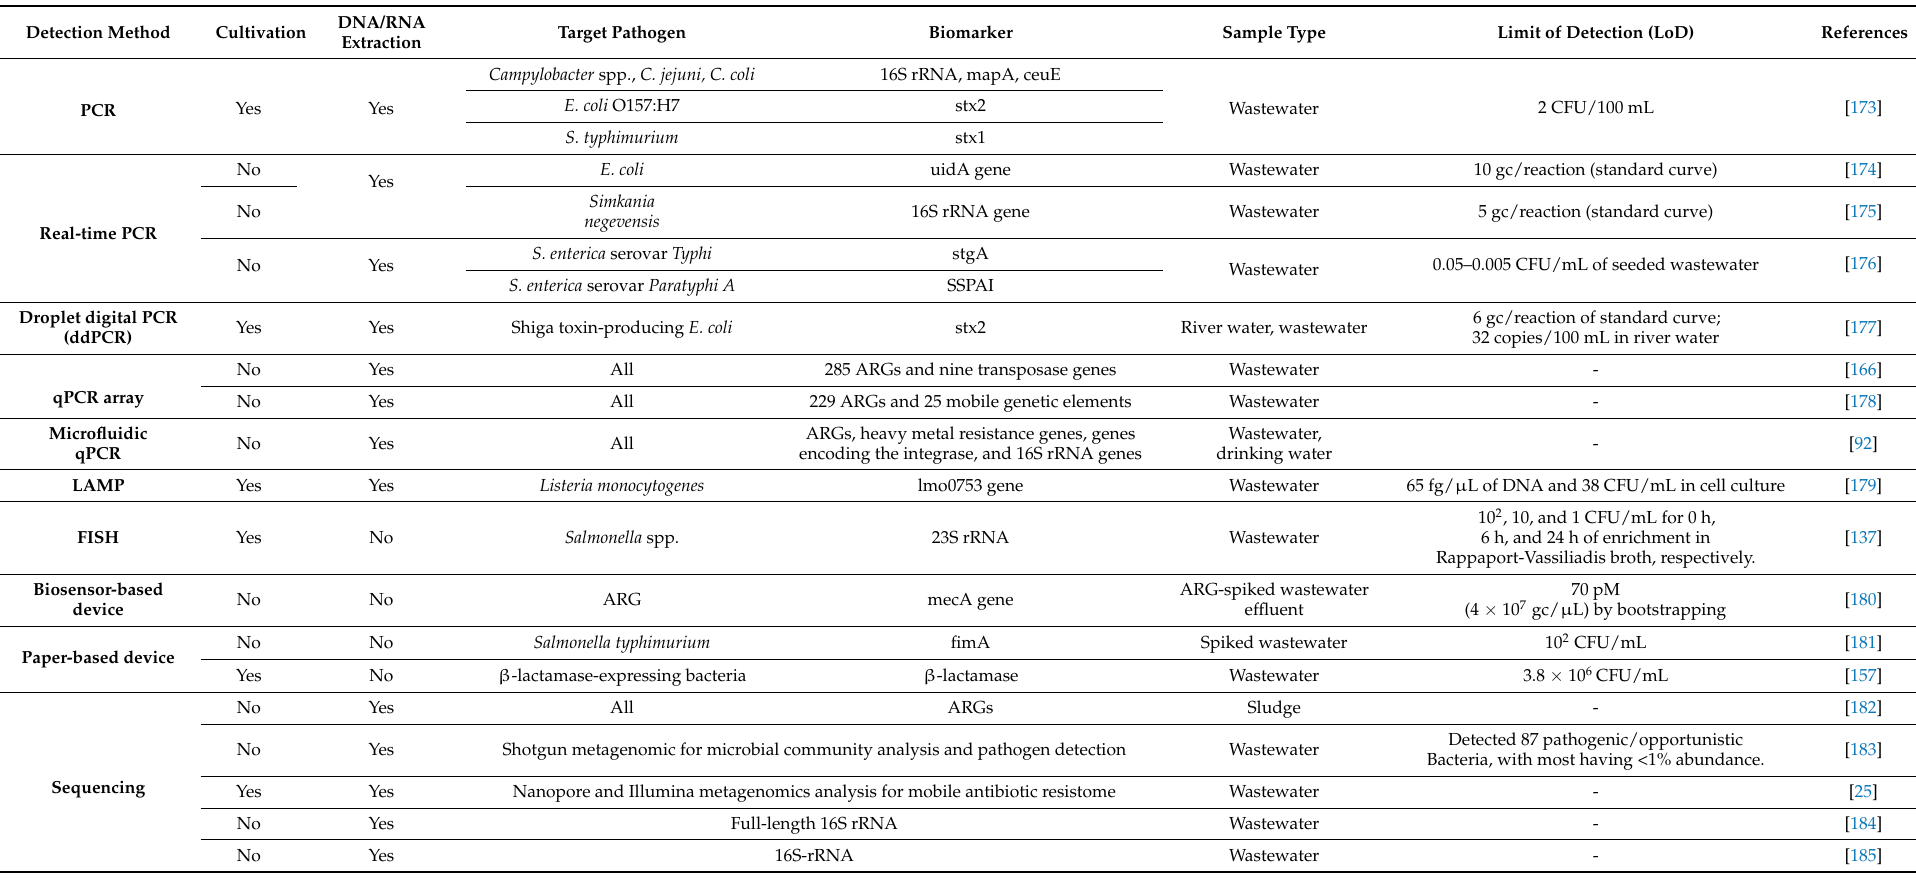
Table 4. Applications of molecular methods in the analysis of pathogenic bacteria in